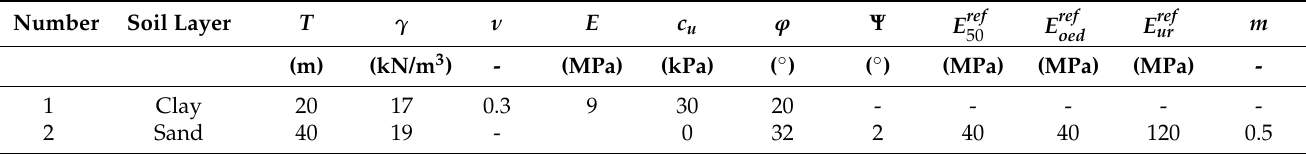
Table 2. Parameters of soil